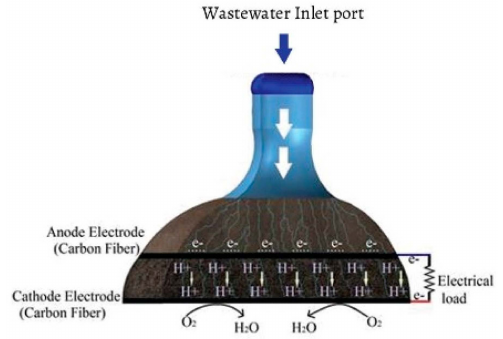
Figure 1. Schematic of the SMFCs installed for BOD monitoring.